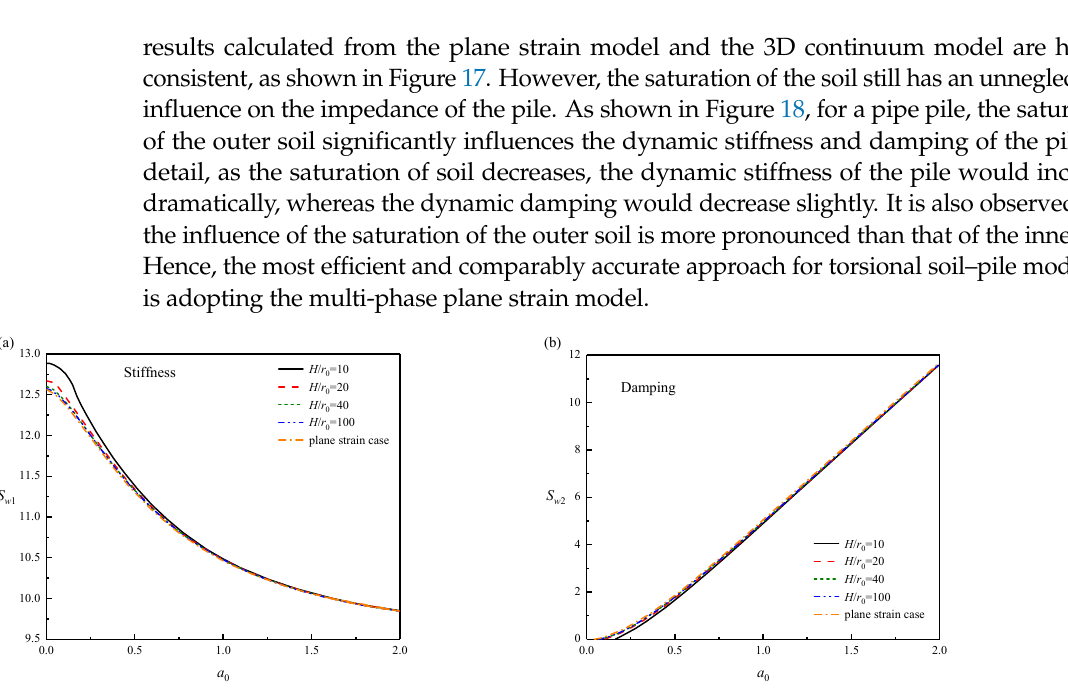
Figure 17. Comparisons between the plane strain and 3D continuum model for torsional soil–pile interaction modeling (reproduced from Wang et al. (2008) [189]): ( a ) dynamic stiffness; ( b ) dynamic damping.